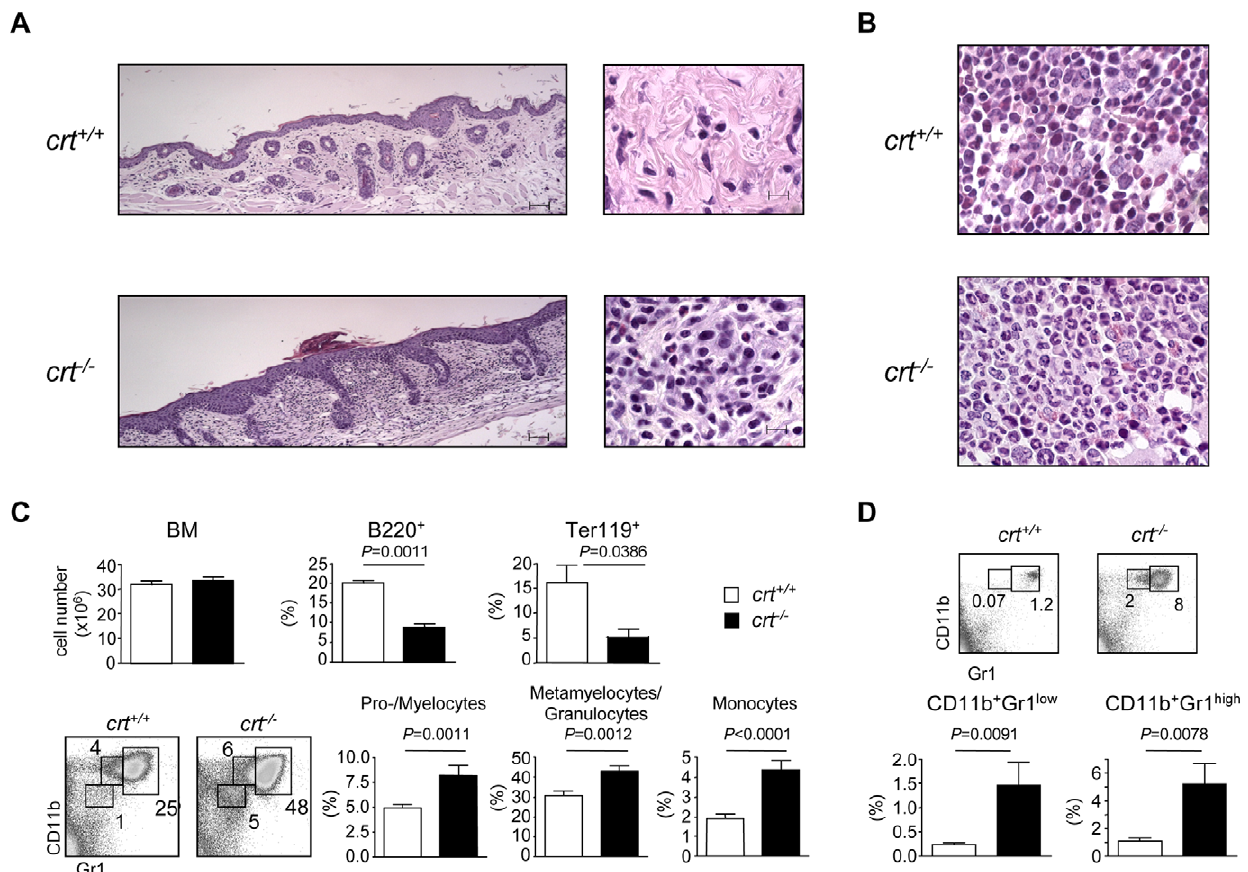
Figure 1. Histopathology and enhanced granulopoiesis in crt 2 / 2 FLC. (A) H&E stained sections show dermal granulocytic inflammatory infiltrate in the skin of crt 2 / 2 FLC at week 12 post-transplant, as opposed to crt + / + FLC, where inflammatory cells are absent (bar=50 m m in left panels; bar=10 m m in right panels). (B) Bone marrow sections of crt 2 / 2 FLC reveal a pronounced increase in myeloid precursors with left-shifted maturation and marked reduction of red cell precursors; crt + / + FLC retain the physiological myelo-erythroid ratio (original magnification, 63 6 ). (C) Bone marrow cellularity with relative representations of B220 + ( crt + / + , n=35, crt 2 / 2 , n=39) and Ter119 + ( crt + / + , n=8, crt 2 / 2 , n=5) cells (top) at weeks 12–18 after reconstitution; dot plot analysis of BM cells stained with CD11b and Gr-1 antibodies and histograms with distribution of the indicated subsets ( crt + / + , n=16, crt 2 / 2 , n=10). (D) Dot plot analysis of splenocytes stained with CD11b and Gr-1 antibodies and histograms with distribution of the indicated subsets ( crt + / + , n=11, crt 2 / 2 , n=9). White bars: crt + / + FLC; black bars: crt 2 / 2 FLC.